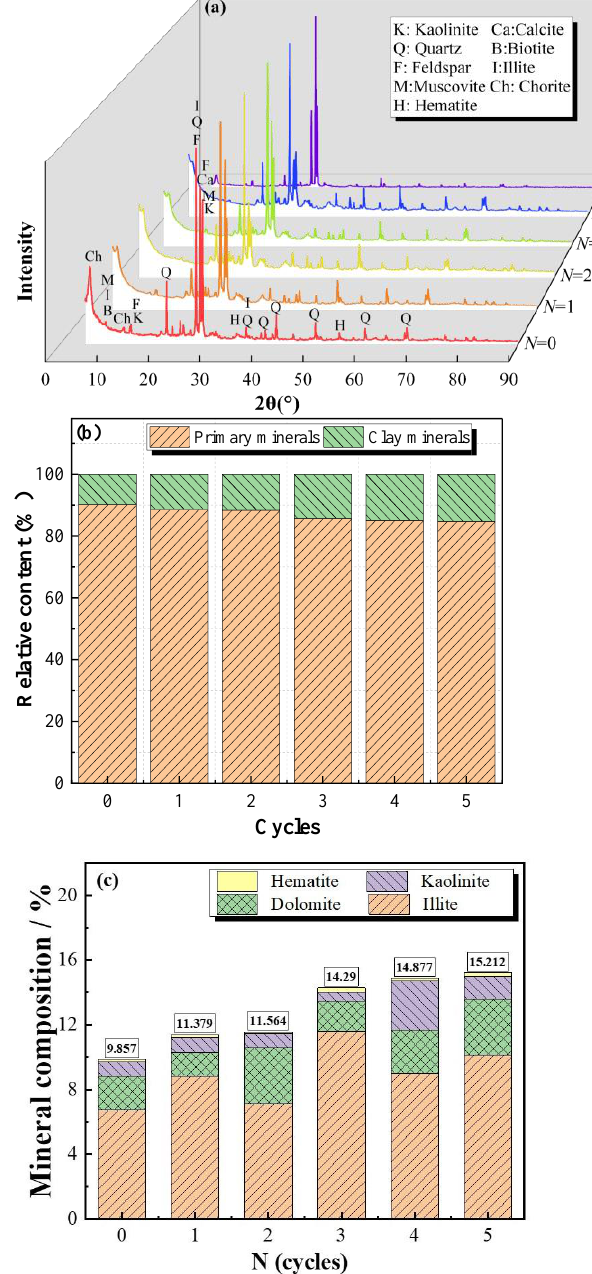
Figure 6. XRD results of specimens at different wet–dry cycles: ( a ) XRD; ( b ) minerals; and ( c ) primary clay minerals.